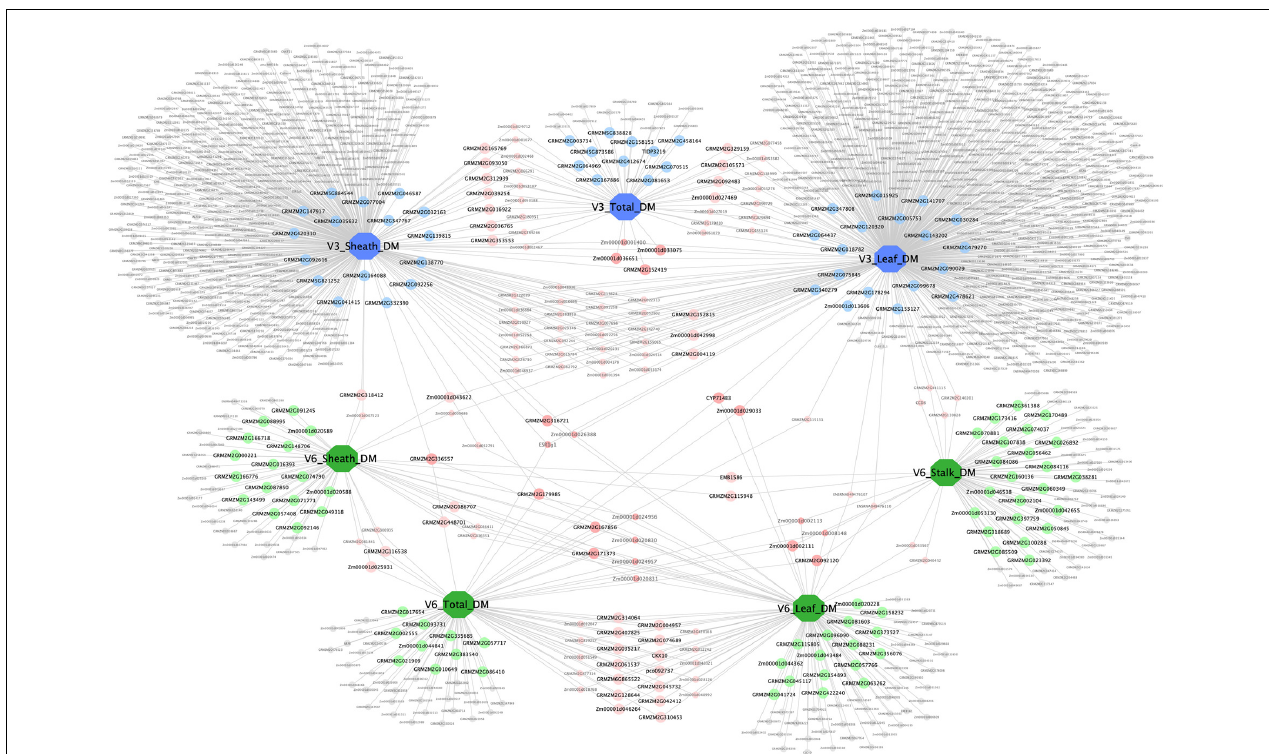
FIGURE 7 | Trait–gene network of dry matter traits. The trait–gene network constructed by dry matter traits and their related genes. Traits and genes are shown in different shapes and sizes. Of the seven large octagon nodes, the three blue nodes represent stage V3 traits (V3 Leaf DM, V3 Sheath DM, and V3 Total DM), and the four green nodes represent stage V6 traits (V6 Leaf DM, V6 Sheath DM, V6 Stalk DM, and V6 Total DM). Genes are represented by round nodes, and different colors and size indicate different attributes. The 158 genes with detailed functional descriptions were labeled as large round nodes, with colors corresponding to their related traits. The gray small nodes represent genes that correlate with only one specific trait, and the pink and red nodes (both large and small ones) indicate two-trait shared genes and three-trait shared genes,